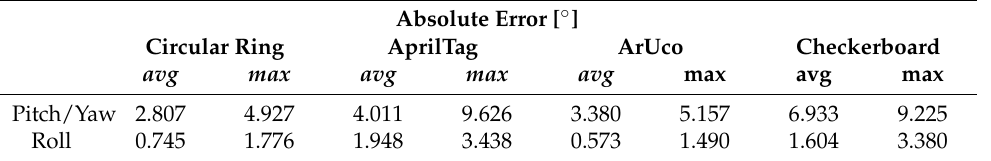
Table 10. Errors of angle estimates.